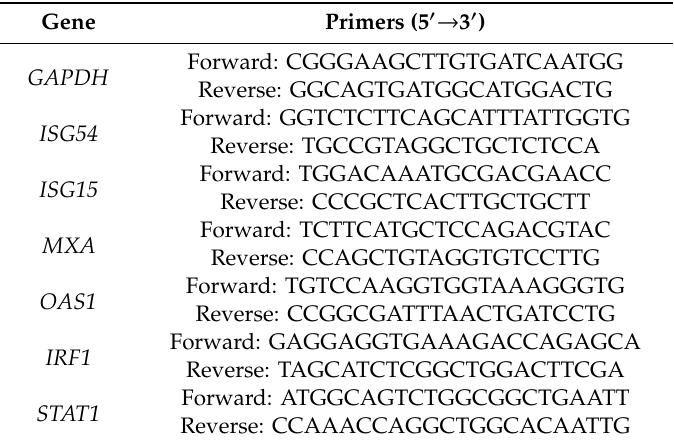
Table 2. The qPCR primers used in present